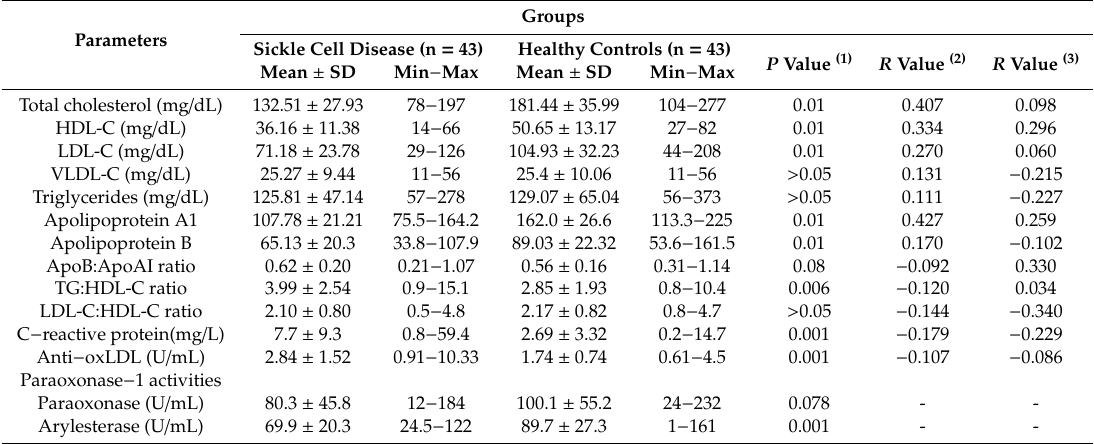
Table 3. Lipid profile and PON-1 activities in patients with sickle cell disease and healthy controls. Groups Parameters Sickle Cell Disease (n =